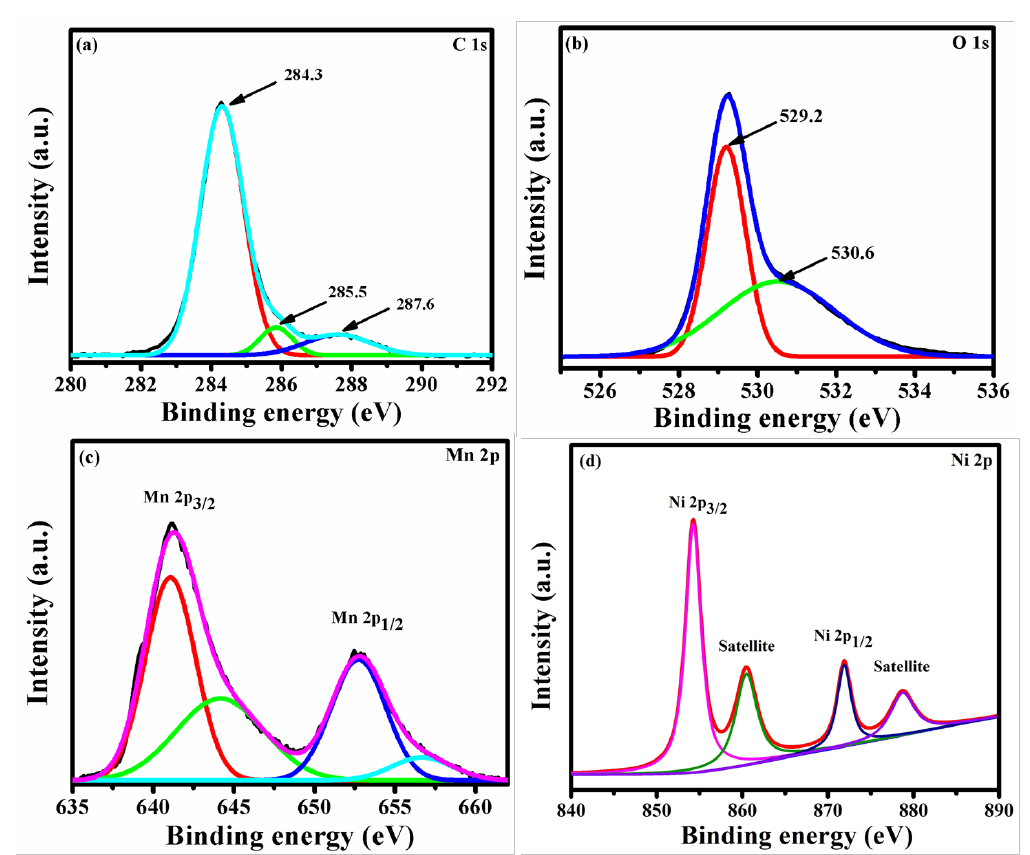
Figure 2. XPS of NMO contains core scan of ( a ) C 1s, ( b ) O 1s, ( c ) Mn 2p, and ( d ) Ni 2p. J. Compos. Sci. 2021 , 5 , x FOR PEER REVIEW